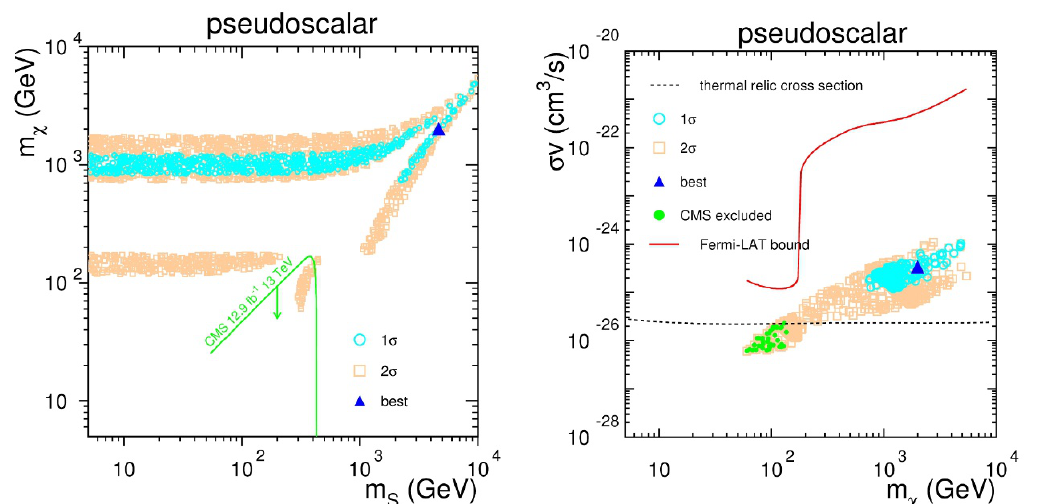
Figure 5 . Left: the AMS-02 favored region of masses ( m (cid:31) vs. m S ) in the simpli(cid:12)ed dark matter model with a pseudoscalar mediator we consider. The solid circles and squares estimate 1 (cid:27) and 2 (cid:27) con(cid:12)dence regions, respectively. The best (cid:12)t point is indicated by a triangle. The green curve is the LHC exclusion limit [41]. Right: the AMS-02 favored region of cross sections ( (cid:27)v vs. m (cid:31) ). The green points are excluded by LHC search. The red curve is the converted upper bound from Fermi-LAT, i.e. the right hand side of eq. (4.2). The black dashed curve corresponds to the thermal cross section [46].